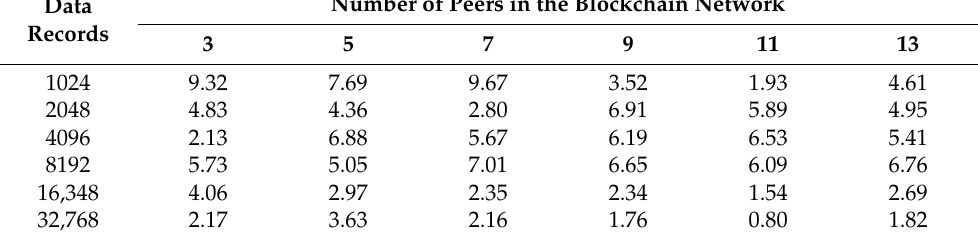
Table 4. Model inference overhead (in%) for the EEG eye state dataset, calculated from a median of 100 runtime ratios. The overall median from 3600 runs (6 × 6 × 100 runtime ratios) was 4.06% and the overhead was above zero for 85.51% of all runs.